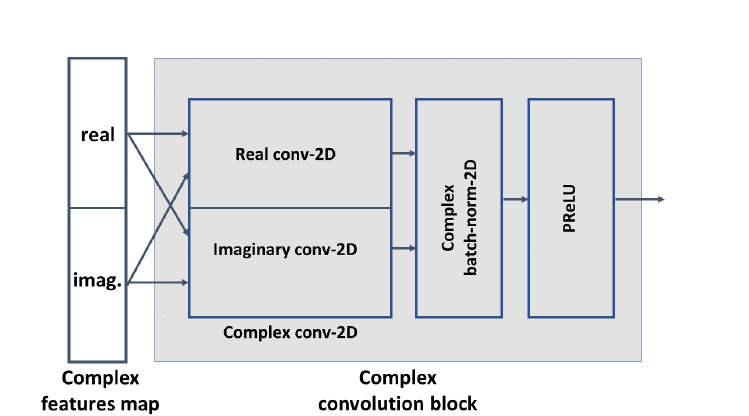
Figure 3. Structure of a complex convolution block. The input features map, consisting of real and imaginary parts, was fed to a complex 2-D convolution layer, the outputs of which were fed to a complex 2-D batch normalization layer. A PReLU activation function provided the block’s